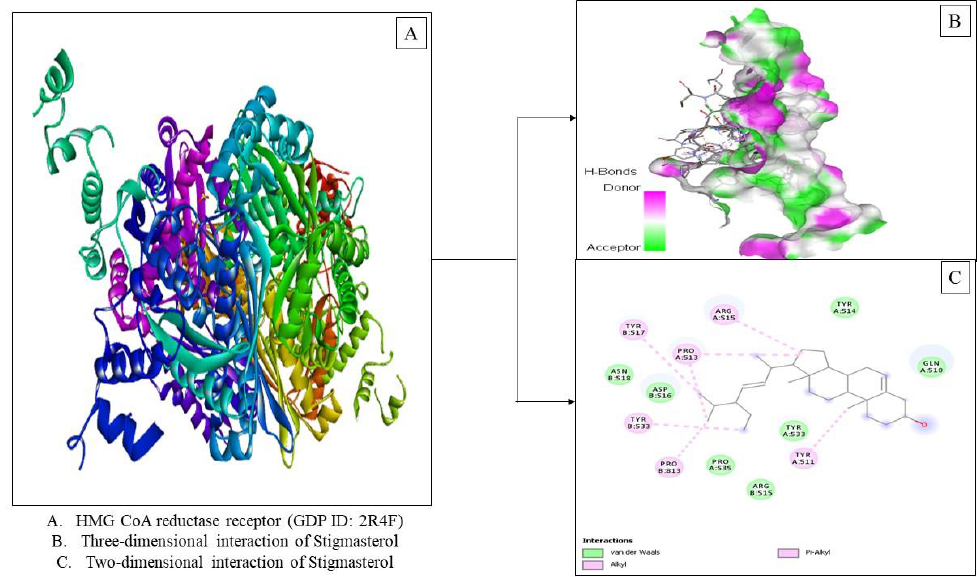
Figure 3. Visualization of the HMG-CoA reductase receptor docking (PDB ID: 2R4F) with stigmas- terol.